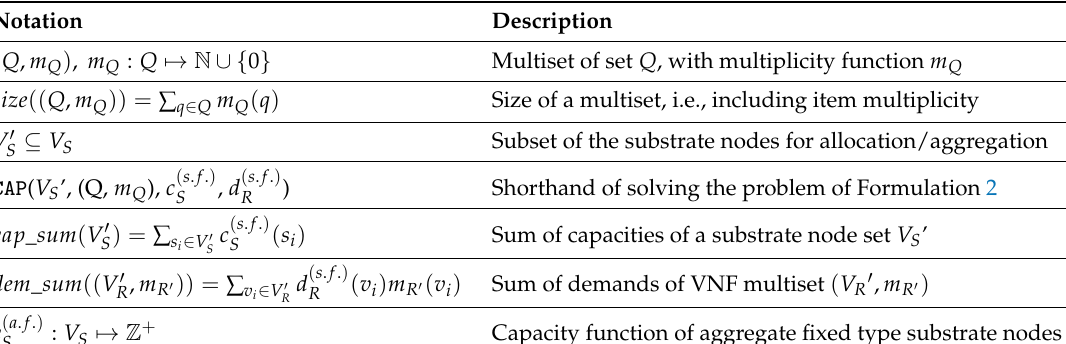
Capacity function of aggregate fixed type substrate